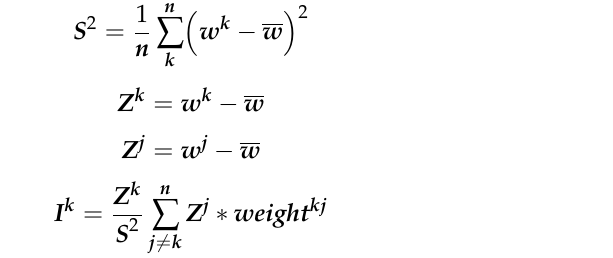
Spatial Association) [40] figure to present the spatial distribution of sidewalks’ relative widths analysis, is a bottom ‐ up systematic clustering in theory. The Anselin Local Moran’s I algorithm calculates the Moran’s I index and z ‐ score for each input point.